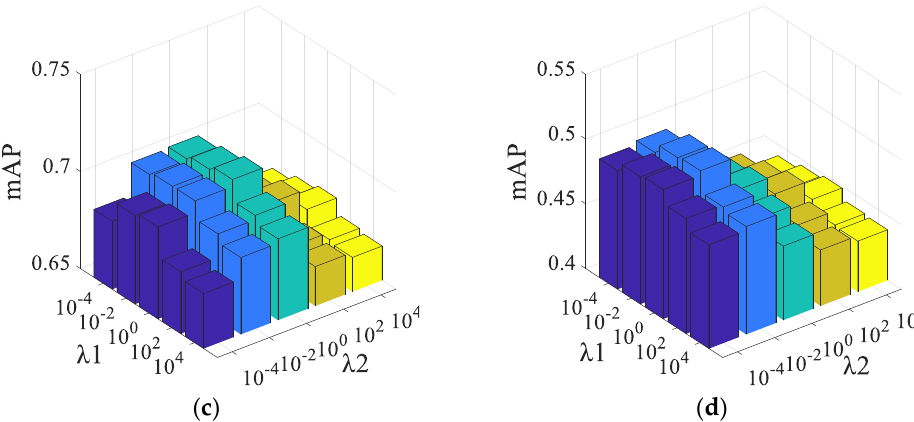
Figure 8. Parameter analysis of λ 1 and λ 2 in LHH on: ( a ) UCMD; ( b ) SAT4; ( c ) SAT6; and ( d ) CIFAR10.